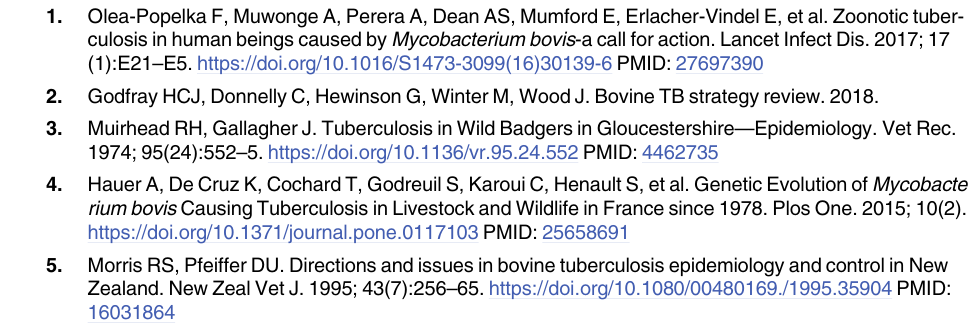
unsampled cases are shown in red and blue